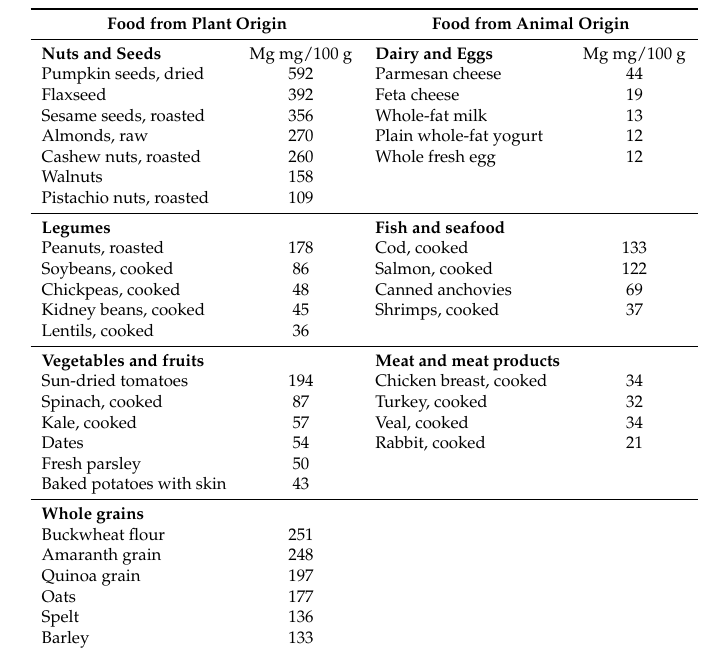
Figure 1. Summary of current Recommended Daily Allowances (RDAs) for magnesium intake [2] and key biological functions of magnesium. Abbreviations: mo, months; y, years. * indicates Adequate Intake. Table 1. List of foods and food groups from plant and animal origin with their corresponding magnesium content (mg/100 g edible food).